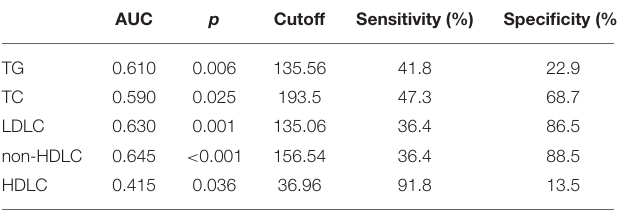
TABLE 3 | Predictive abilities of lipid levels for clinical outcomes.